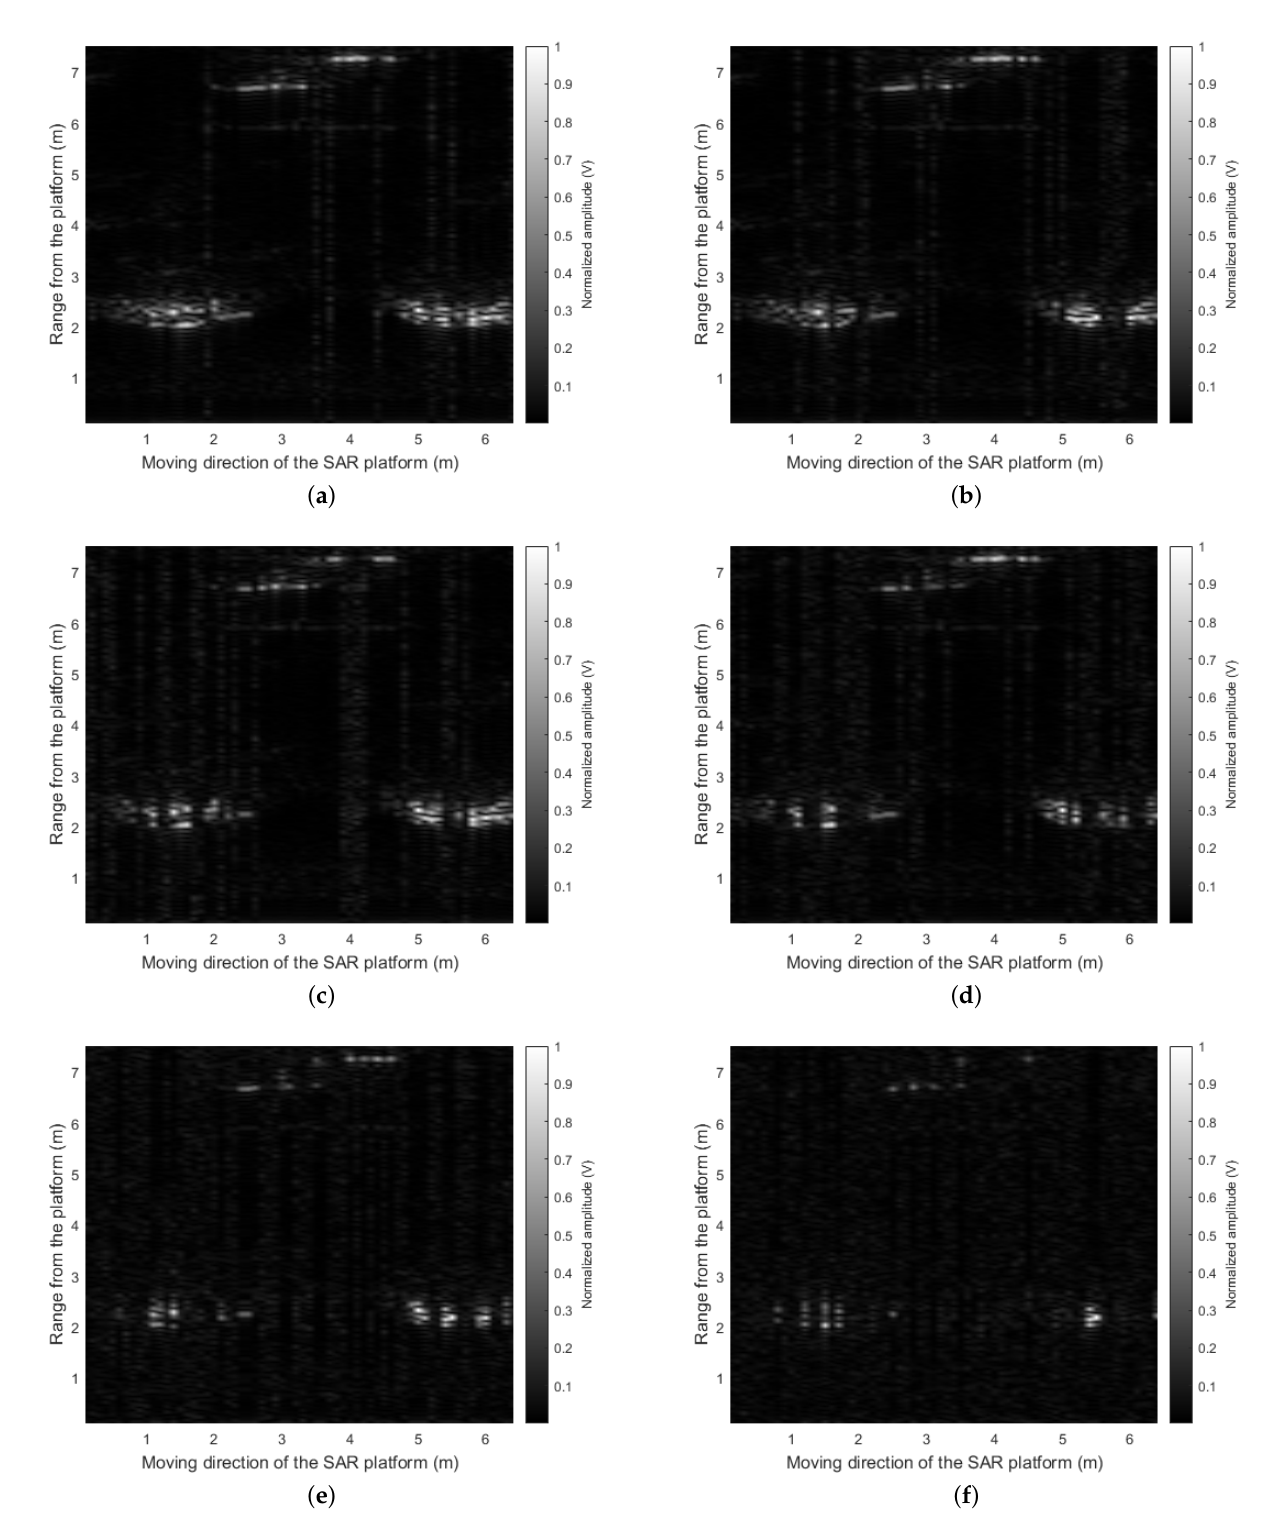
Figure 11. SAR image reconstruction result using the CS-based signal recovery: ( a ) 90% of the total radar sensor data used; ( b ) 80% of the total radar sensor data used; ( c ) 70% of the total radar sensor data used; ( d ) 60% of the total radar sensor data used; ( e ) 40% of the total radar sensor data used; ( f ) 20% of the total radar sensor data